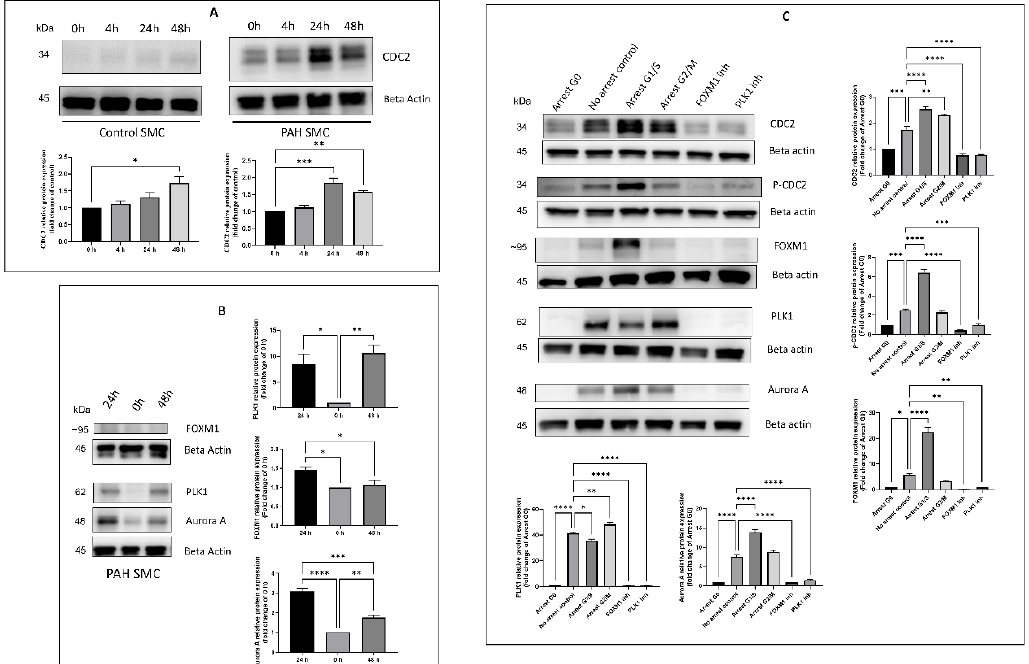
Figure 2. Effect of timing, cell cycle arrest, and FOXM1/PLK1 inhibition on the expression of CDC2. ( A ) Western blots showing expression of CDC2 in control and PAH HPASMC at time 0, 4, 24, or 48 h after release from 48 h serum starvation. ( B ) Western blots showing expression of FOXM1, PLK1, Aurora A, and beta actin in PAH HPASMC at 0, 24, and 48 h after release from serum starvation. ( C ) Western blots showing expression of CDC2, p-CDC2 (Tyr15), FOXM1, PLK1, Aurora A, and beta actin after arrest in G0 (serum starvation), arrest G1/S (amphicolin treatment), arrest G2/M (nocodazole treatment), FOXM1 inhibition (thiostrepton treatment), PLK1 inhibition (volasertib treatment), or released in 5% FBS (no arrest control). Images are representative of at least triplicate experiments. Bar graphs indicate group means for these experiments and the error bars represent the standard deviation. *- p < 0.05, **- p < 0.01, ***- p < 0.001, and ****- p < 0.0001.